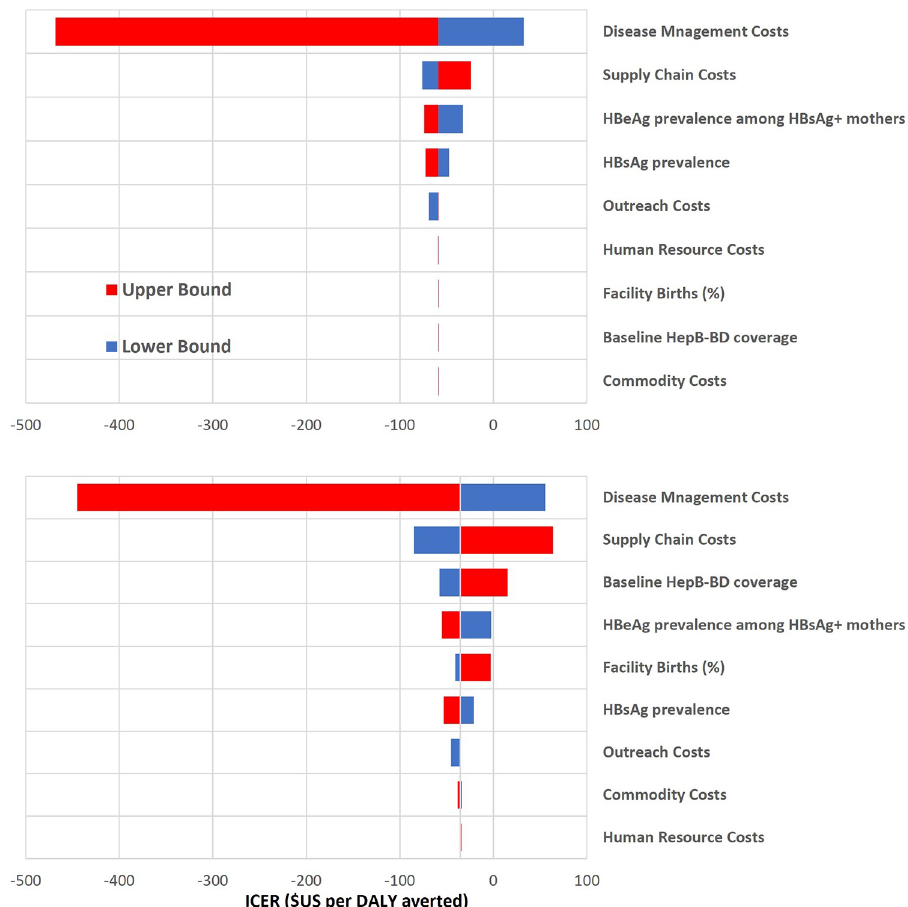
Fig 3. Tornado plots displaying outcomes of one-way sensitivity analysis holding MAP price constant. Notes: Top: 1% additional coverage (scenario 1) within all LMICs. Bottom: Scenario 1 + 1% replacement coverage with MAPs in LMICs (scenario 2). HBsAg and HBeAg upper and lower bounds correspond with values given in Table 2. Facility birth and baseline HepB-BD coverage’s lower bound = 5%, upper bound = 99%. MAPs could reduce outreach costs by 20% for community births vaccinated by a qualified health worker and 50% for community births vaccinated by a trained lay health worker; upper-bound vaccine administration time is estimated at two minutes (120 seconds). Commodity costs used upper and lower bounds of estimates (see Table C in S1 Text), while supply chain costs were doubled or halved for MAPs, as cost impact remains uncertain. Abbreviations: DALY: disability-adjusted life years, HBeAg: hepatitis B envelope antigen, HBsAg: hepatitis B surface antigen, HepB-BD: hepatitis B birth dose, ICER: incremental cost-effectiveness ratio, LMICs: low-and middle-income countries, MAP: microarray patch.